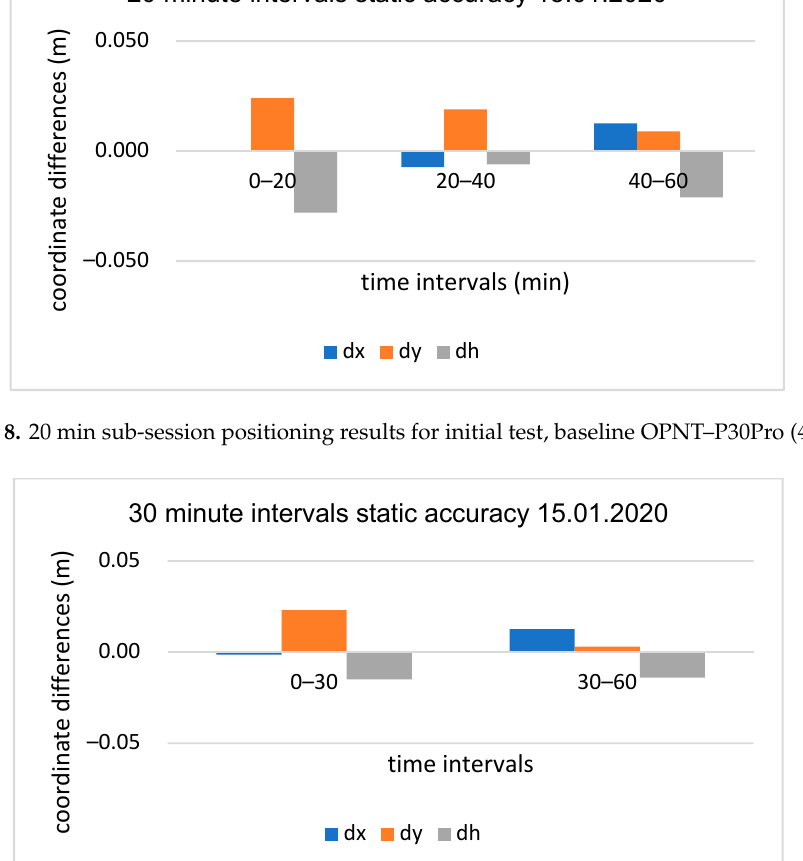
Figure 9. 30 min sub-session positioning results for initial test, baseline OPNT–P30Pro (4 km).